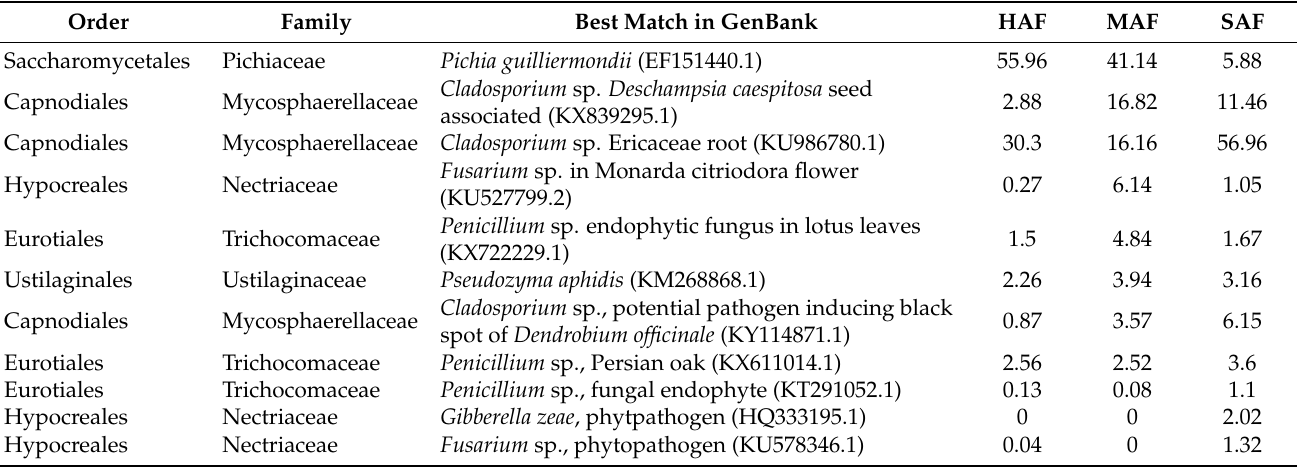
Table 3. Variations in relative abundance (%) of ITS amplicons in aphid-associated fungal libraries. HAF, MAF, and SAF indicate healthy, mycotized, and starved aphid-associated fungi,